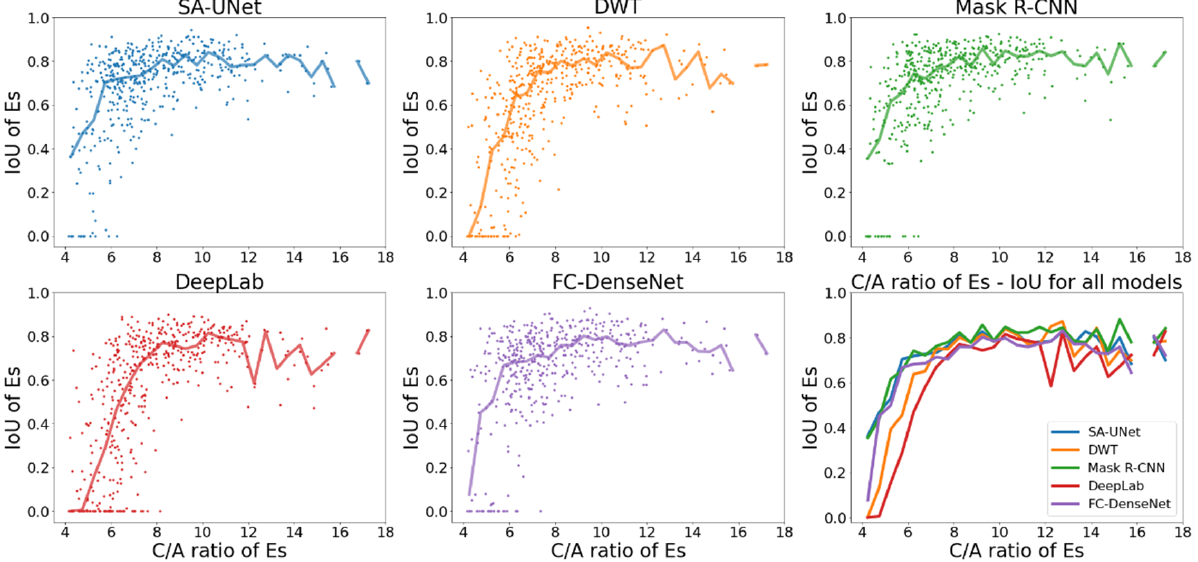
Figure 8. Comparison of IoU of Es vs. C/A ratio for all models (different colors represent different models: blue: SA-UNet, orange: DWT, green: Mask R-CNN, red: DeepLab, purple: FC-DenseNet).